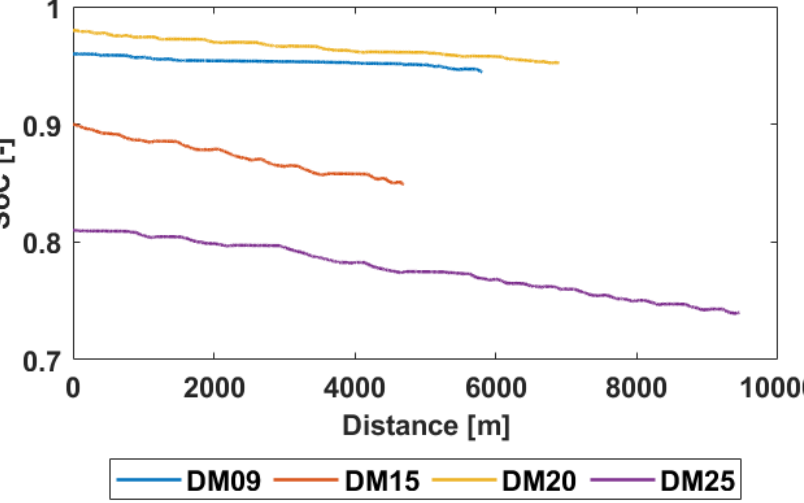
Figure 12. Battery state of charge trajectories of the four experimental driving missions considered for the validation of the model.